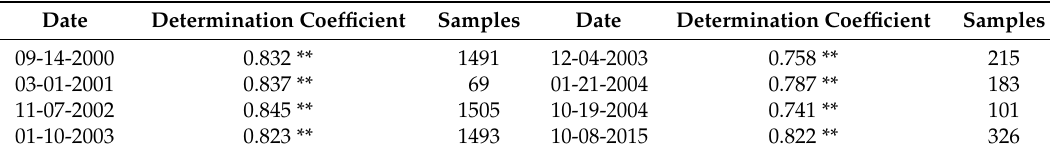
Table 3. Correlation between land surface temperatures retrieved using Landsat and Terra (MODIS LST)